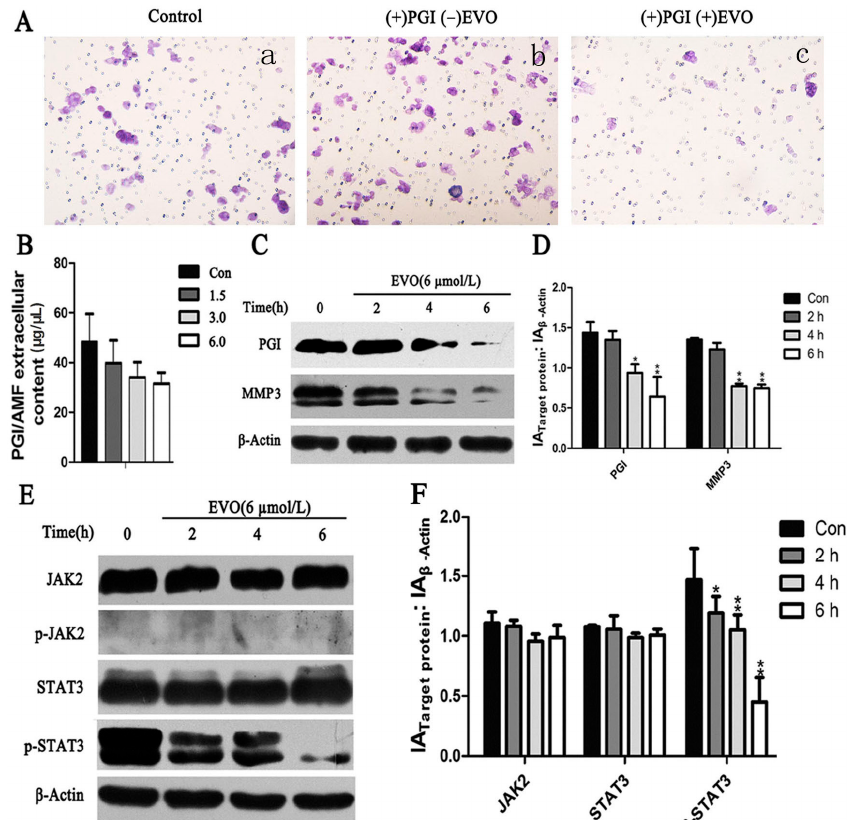
Figure 3. Migration ability, expression of PGI/AMF, JAK2/STAT3, and MMP3 were detected in HCT-116 cells treated with EVO. ( A ) Migration potential was assessed by Transwell assay after cells were treated by agents. Cells were seeded in Transwell insert upper part incubated with 10 µ g/mL PGI/AMF ( b ) and with 10 µ g/mL PGI/AMF + 6 µ mol/L EVO ( c ) for 28 h, normal cells as the control group ( a ) (original magnification, 200 ˆ ); ( B ) AMF was detected by ELISA after cells were treated with various concentrations of EVO for 6 h; ( C – F ) Cells were incubated with 6 µ mol/L EVO for 2, 4, and 6 h, and the expression of PGI, MMP3 and JAK2/STAT3 was assessed. Relative expression ratio was calculated with Gray-scan value for ( D , F ). Data represent the results of three independent experiments (mean ˘ SD). Statistically different compared with the control (0 µ mol/L of EVO) ( * p < 0.05; ** p <